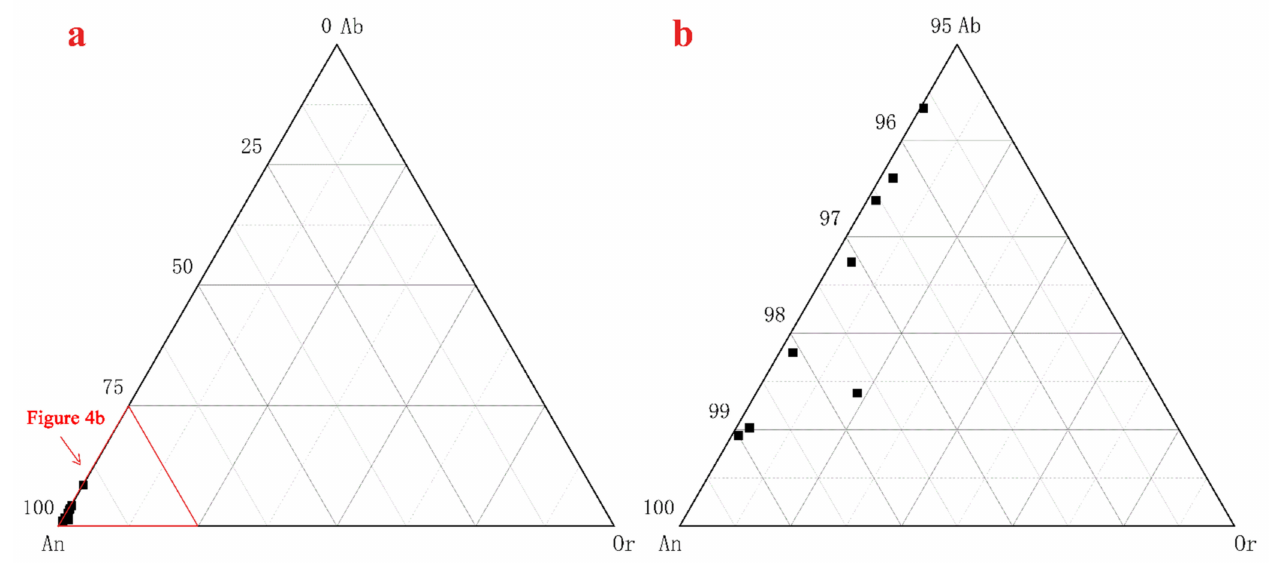
Figure 4. The Or–Ab–An ternary system showing that plagioclase in the samples is anorthite. ( a ) The end members An 91.4–99 Ab 0.94–0.85 Or 0.01–0.91 projected in the Or–Ab–An ternary system; ( b ) zoom-in of Figure 4a, showing that plagioclase in the samples is